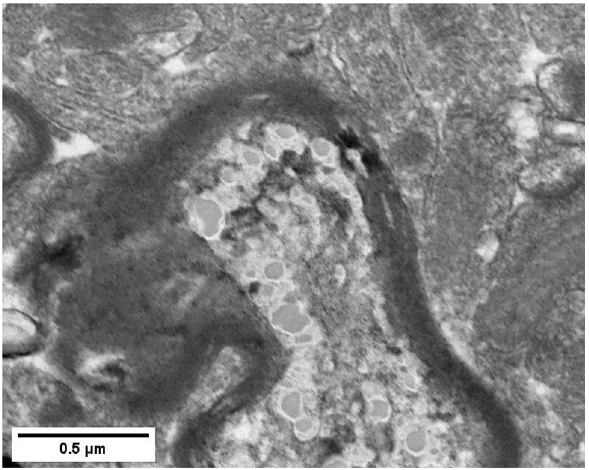
Figure 4. STEM images of damaged axons with loose myelin sheaths in the olfactory bulb of the rats exposed to PbO NPs.